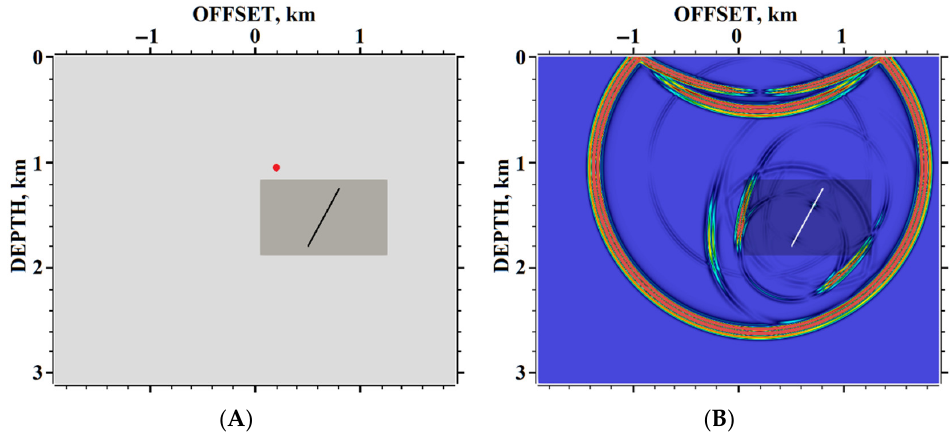
Figure 25. Example #2: ( A ) geophysical model, overlapping curvilinear mesh, the point source is marked by the red dot; ( B ) velocity modulus snapshot.